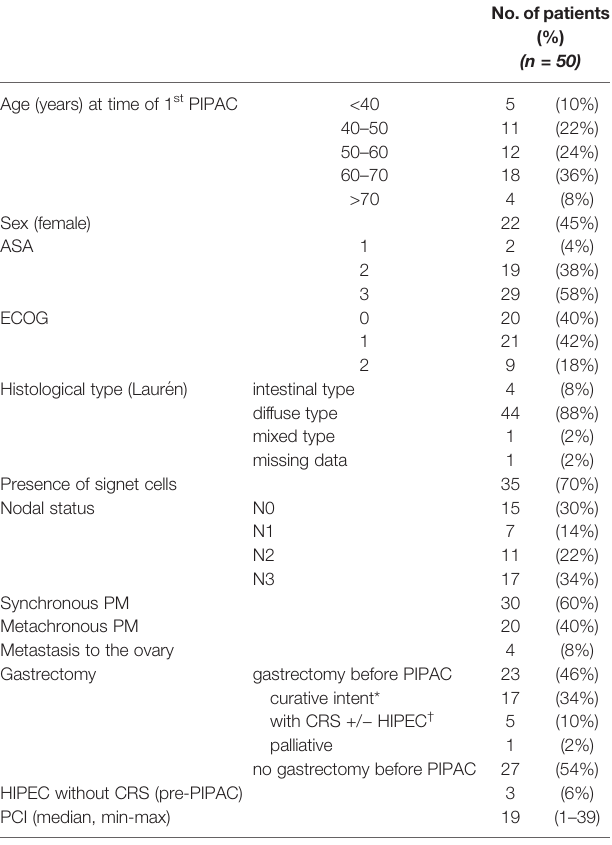
TABLE 2 | Patient cohort: baseline and oncological